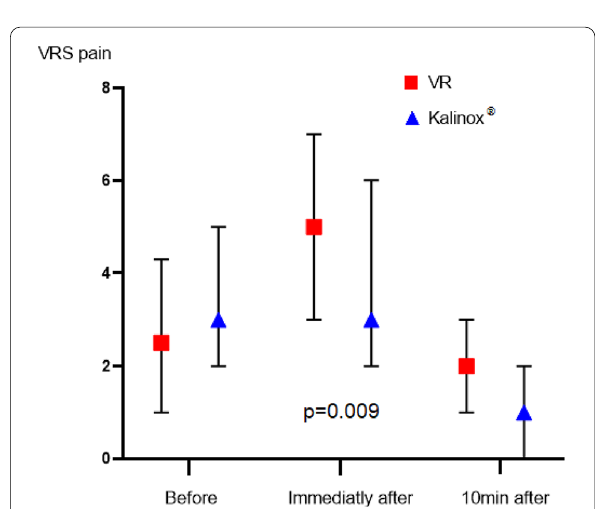
Fig. 3 NRS pain variation during procedure. NRS pain (0–10) in the VR and Kalinox groups before, immediately after, and 10 min after chest drain removal. Data are represented as median with interquartile range. NRS numerical rating scale, VR virtual